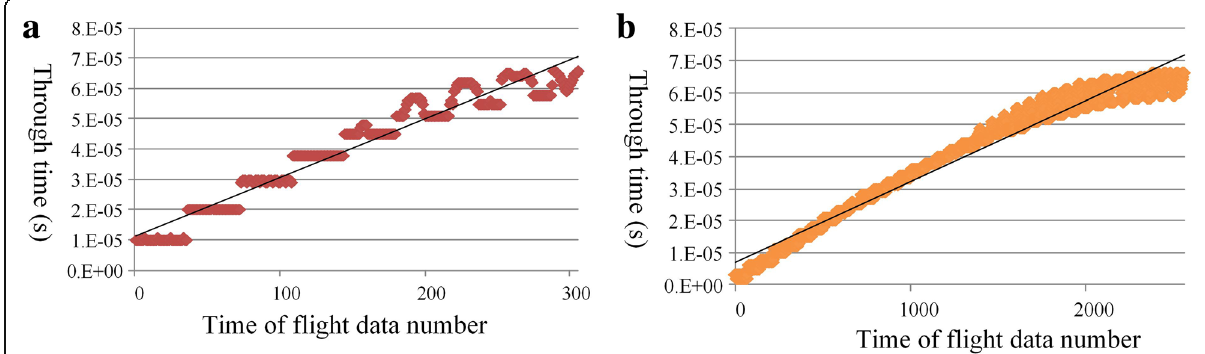
Fig. 5 Data distribution of measurement and interpolation: a distribution of 306 transit time data, b distribution of 2556 transit time